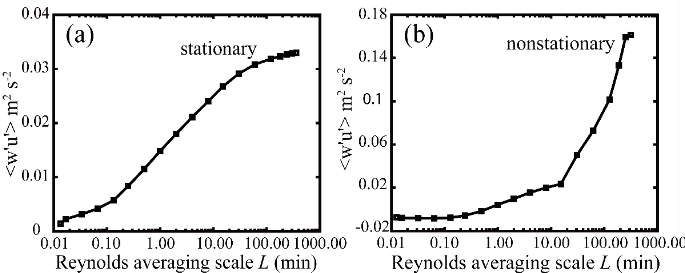
Figure 2. Hourly averaged values of β from 4–6 August 2020. The dotted line represents β = 0.1. If β exceeds 0.1, this episode is classified as nonstationary. Figure 1. Ep. 2, Ep. 3, and Ep. 4 were determined by β < 0.1; these episodes are marked as having a brown shaded background. A distinct stratification emerges with a dividing line of β = 0.1.